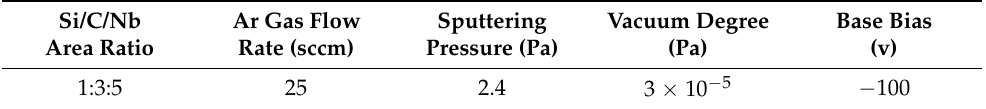
Table 1. Fixed parameters in sputtering deposition.